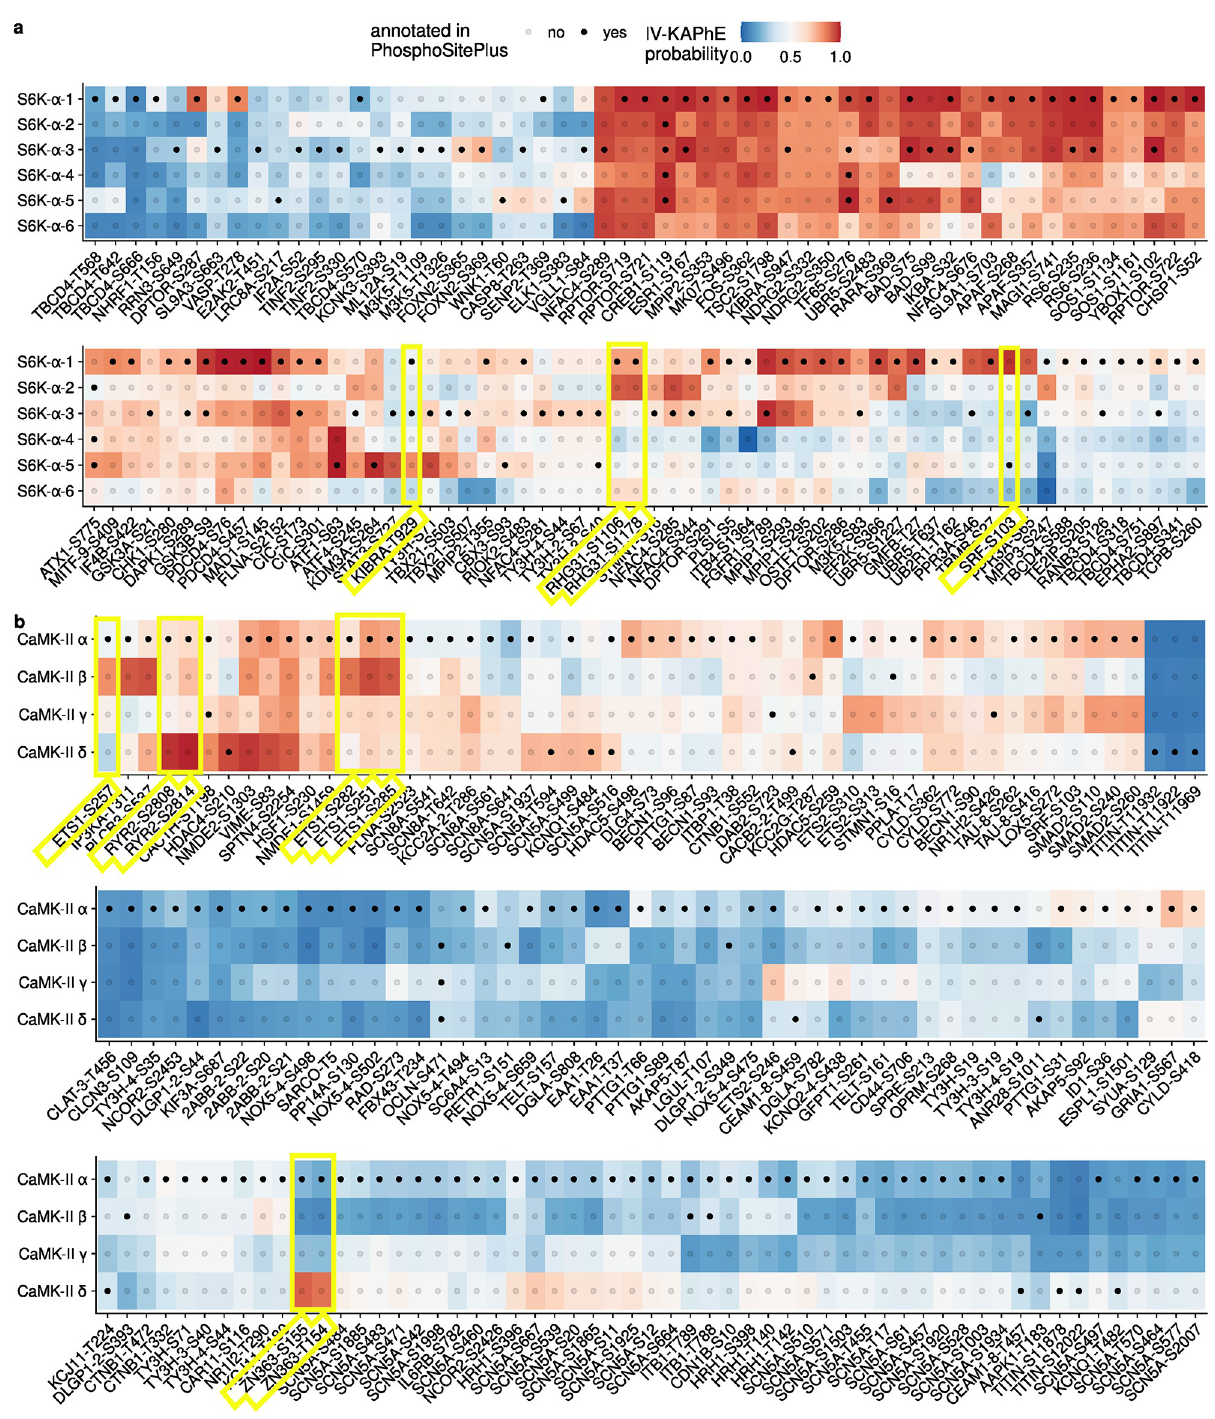
Fig 6. IV-KAPhE can identify instances where literature-derived kinase-phosphosite assignments are probably assigned in error to commonly studied isozyme, instead of a lesser-studied one. a) IV-KAPhE assignments of ribosomal protein S6 kinase alpha isozymes for all sites annotated in PhosphoSitePlus as being phosphorylated by at least one of the isozymes. Red colors indicate assignments predicted as likely by IV-KAPhE. Highlighted sites, discussed in the text, are examples that IV-KAPhE predicts are more likely to be phosphorylated by a different isozyme than the one annotated. b) IV-KAPhE assignments of calcium/calmodulin-dependent protein kinase type II subunits to annotated sites, as described in (a).